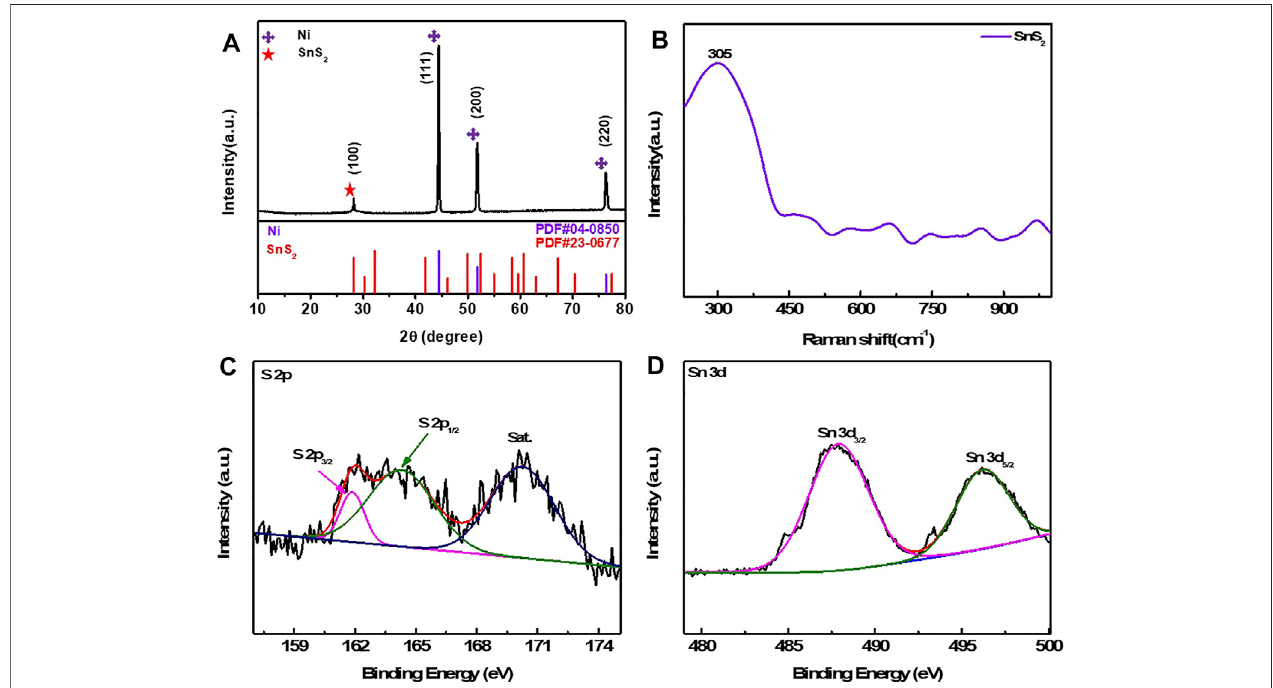
FIGURE 1 | (A) XRD pattern of the Ni@SnS 2 nanosheet arrays; (B) Raman spectrum; XPS survey spectra of (C) S 2p and (D) Sn